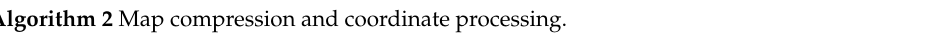
Algorithm 2 Map compression and coordinate processing.